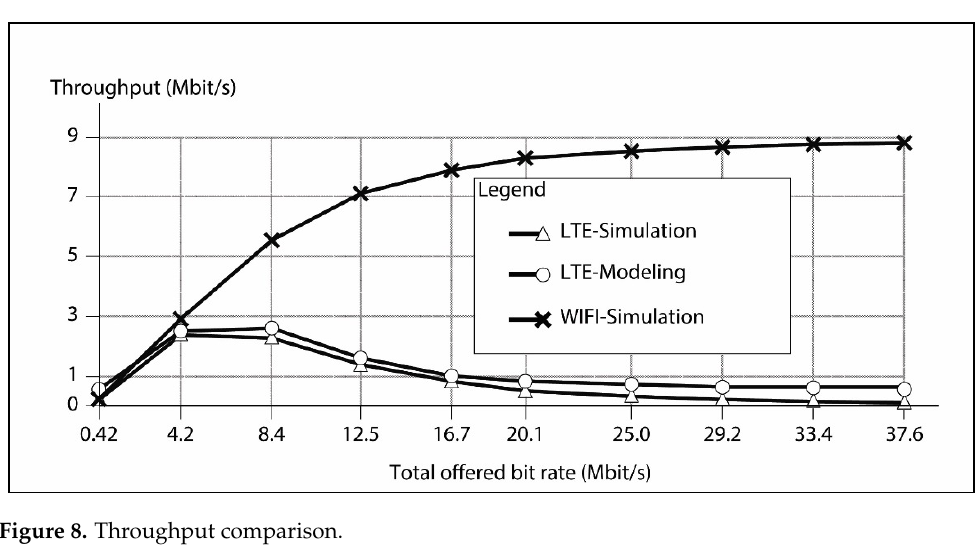
Figure 8. Throughput comparison.